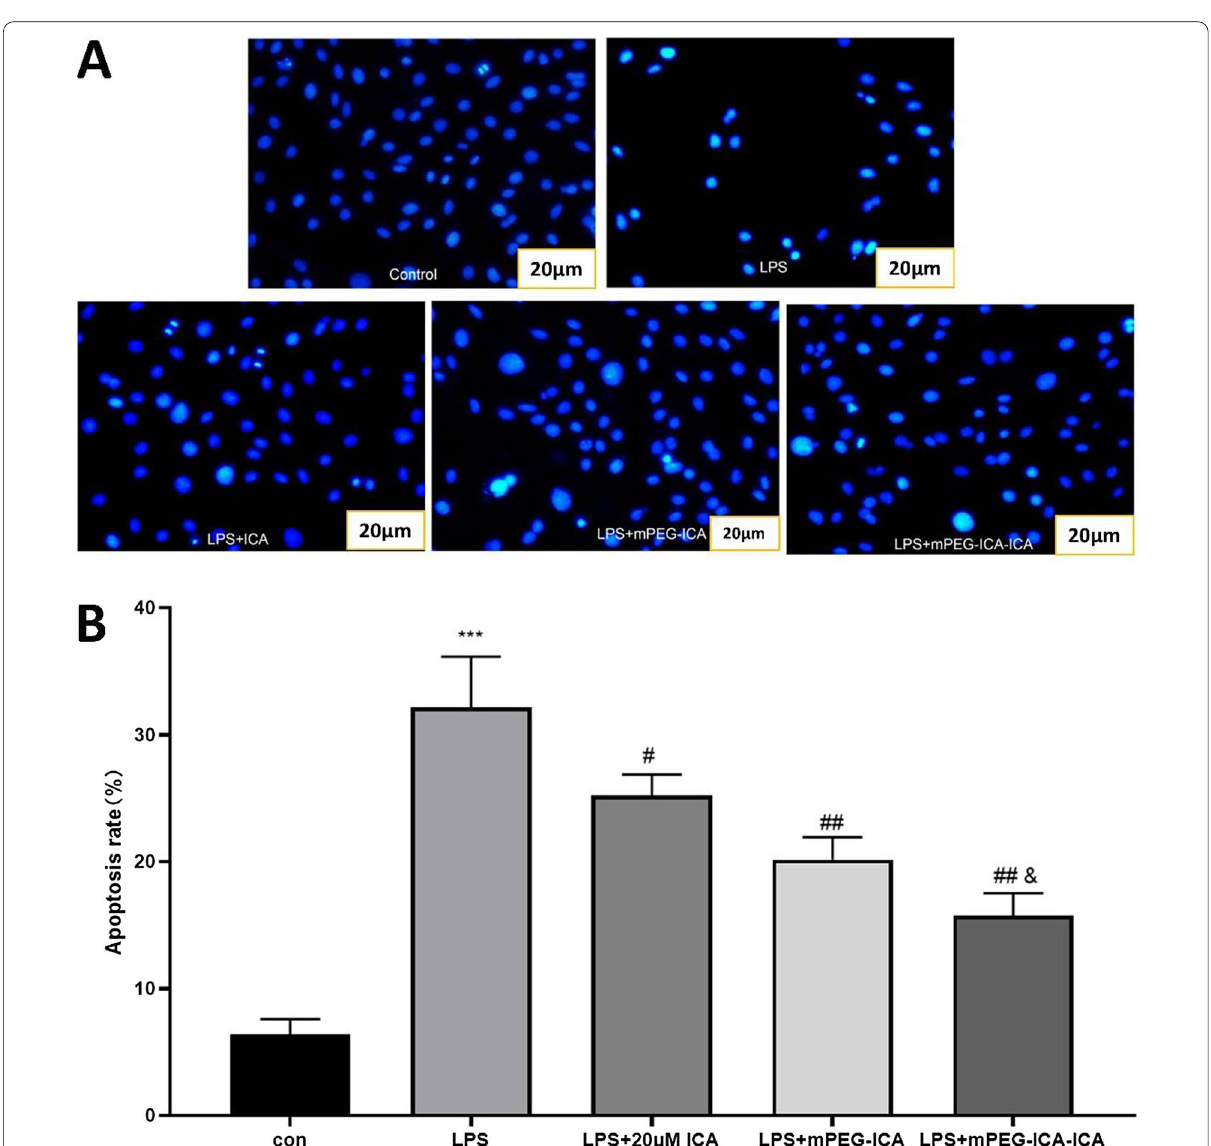
Fig. 8 Detection of apoptosis by Hoechst 33,258 staining. A Nuclear morphology in cells stained with Hoechst 33,258. B Quantitative analysis of the apoptosis rate by Hoechst 33,258 staining. Data are the mean